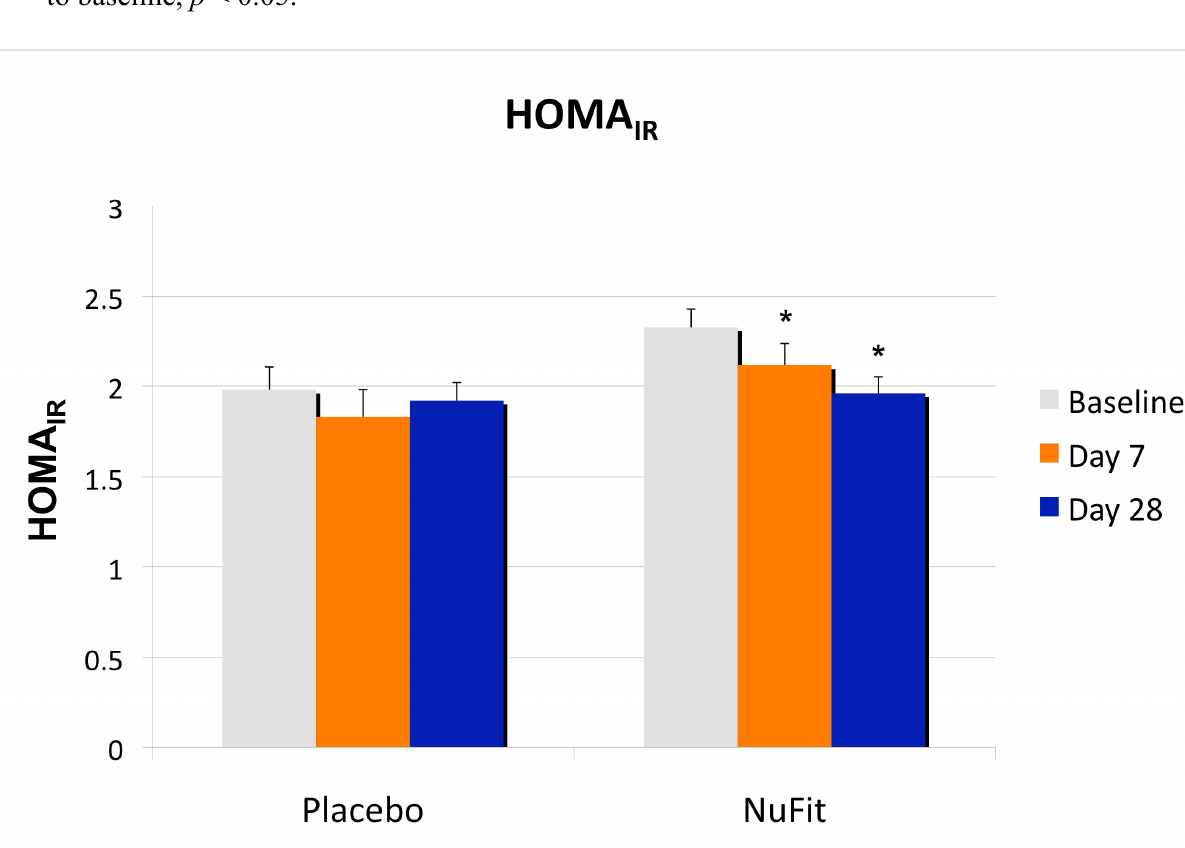
Figure 2. The effects of the NuFit active blend and placebo on insulin sensitivity, measured by HOMA . Twenty overweight or obese subjects received the NuFit active IR blend or placebo for 4 weeks. Plasma glucose and insulin concentrations were assessed at baseline, days 7 and 28. The homeostasis model assessment of insulin resistance (HOMA ) IR was used as a screening index of changes in insulin sensitivity and was calculated via standard formula from fasting plasma insulin and glucose (HOMA = [Insulin (uU/mL) × IR glucose (mM)]/22.5). Values are expressed as mean ± SE. * Denotes significant difference to baseline, p <